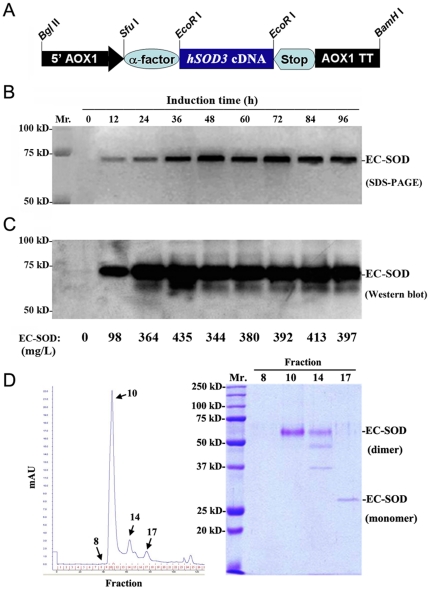
Production and secretion of rhEC-SOD in Pichia pastoris.
A. Structure of the P. pastoris α-factor/human-EC-SOD secretion cassette. The hSOD3 cDNA fragment was cloned into pPICZαA vector The AOX1 gene can easily be induced by methanol. B. Representative SDS-PAGE analysis of time course of rhEC-SOD expression and secretion in the yeast cultures after methanol induction. C. Western blot analysis of secreted rhEC-SOD with a mouse anti-human EC-SOD monoclonal antibody. The amount of rhEC-SOD was determined quantitatively by ELISA. Results are representative of three experiments. D. The purification of rhEC-SOD by FPLC system. The purity and molecular weight of purified rhEC-SOD (fraction No. 10) was checked by 12% SDS-PAGE.